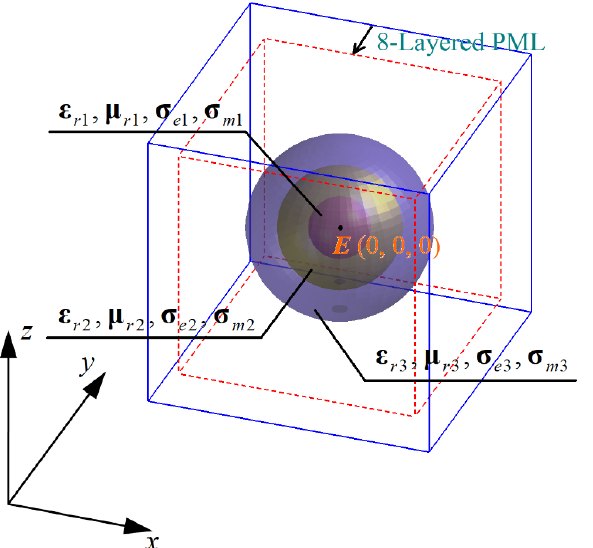
Figure 7. Three-dimensional multi-layer spheres with biaxial anisotropy where E (0, 0, 0) is denoted Figure 7. Three ‐ dimensional multi ‐ layer spheres with biaxial anisotropy where E (0,0,0) is denoted as the observation point in time domain. as the observation point in time